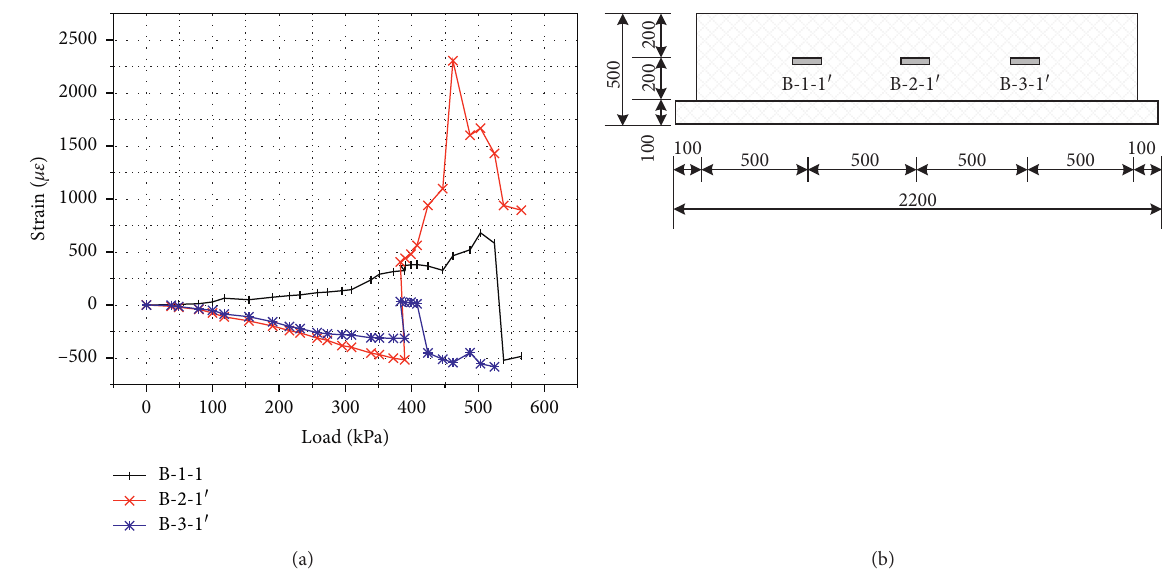
Figure 11: Strain evolution of B1. (a) Load-strain curve. (b) Measuring points of cover